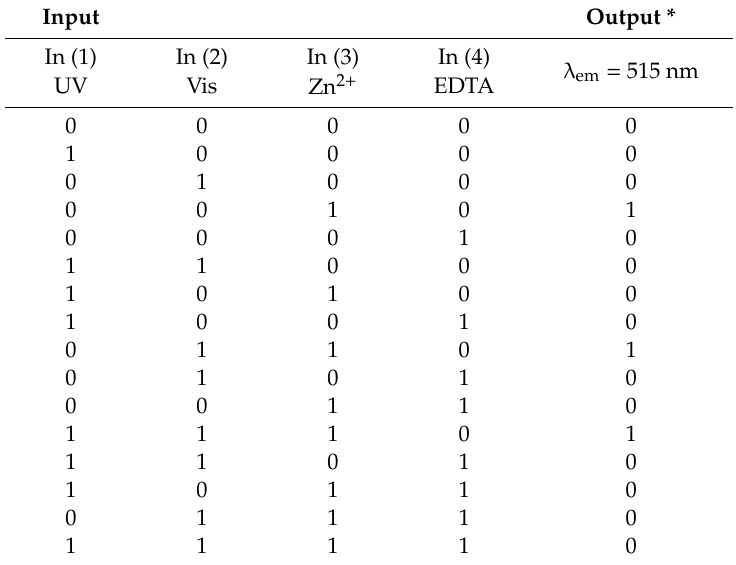
Table 1. Truth table highlighting the possible binary inputs and the corresponding digital output.